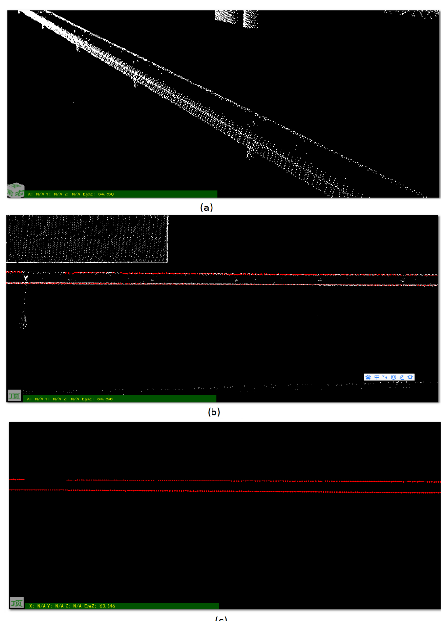
Figure 1. Roadside double layer isolation belt.